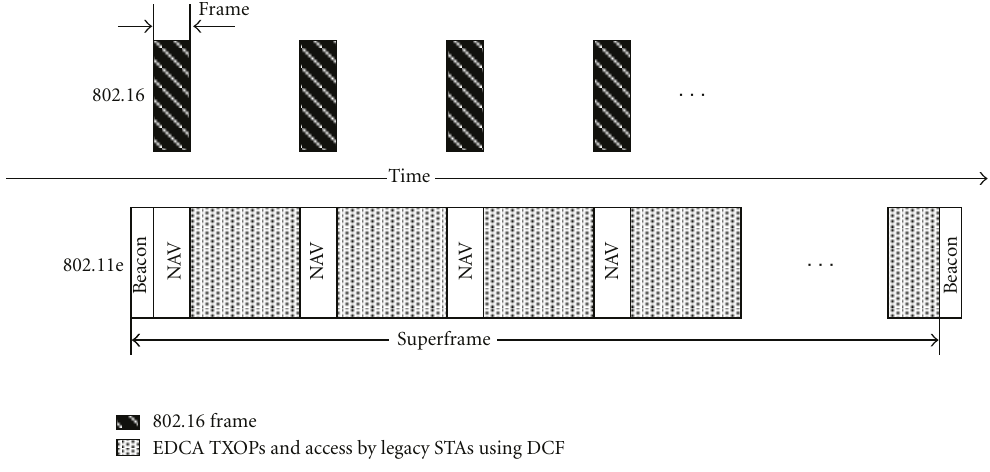
Figure 5: Medium access cooperations between IEEE 802.16 and IEEE